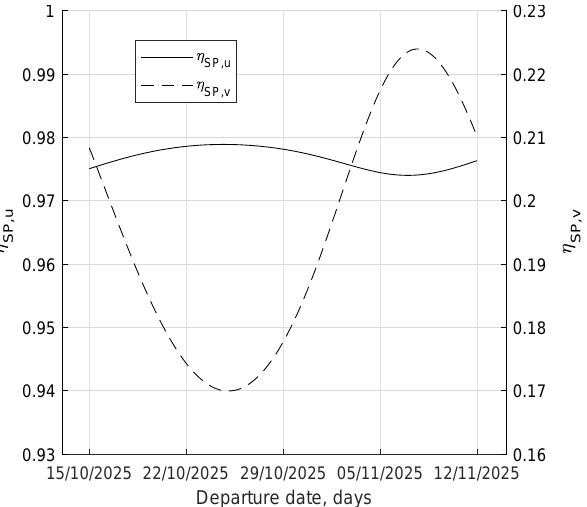
Figure 8. Radial and tangential overall perturbation effect per trajectory for escapes from SEL2.